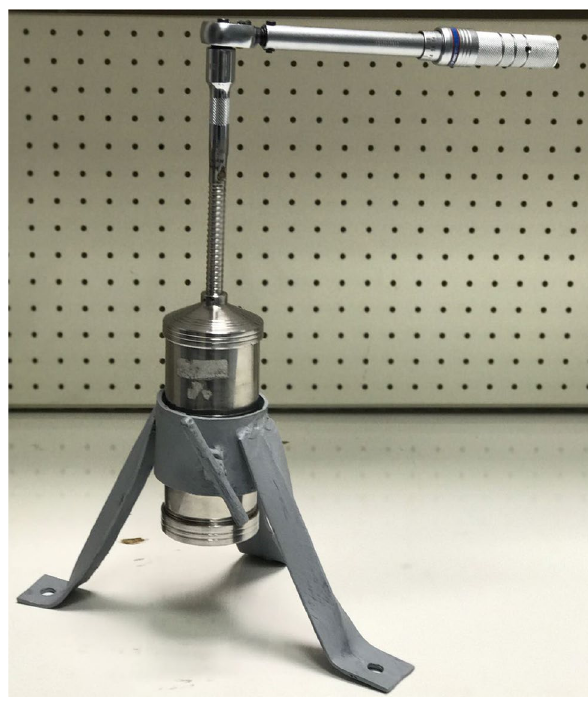
Fig. 1 Qualitative hardness test apparatus